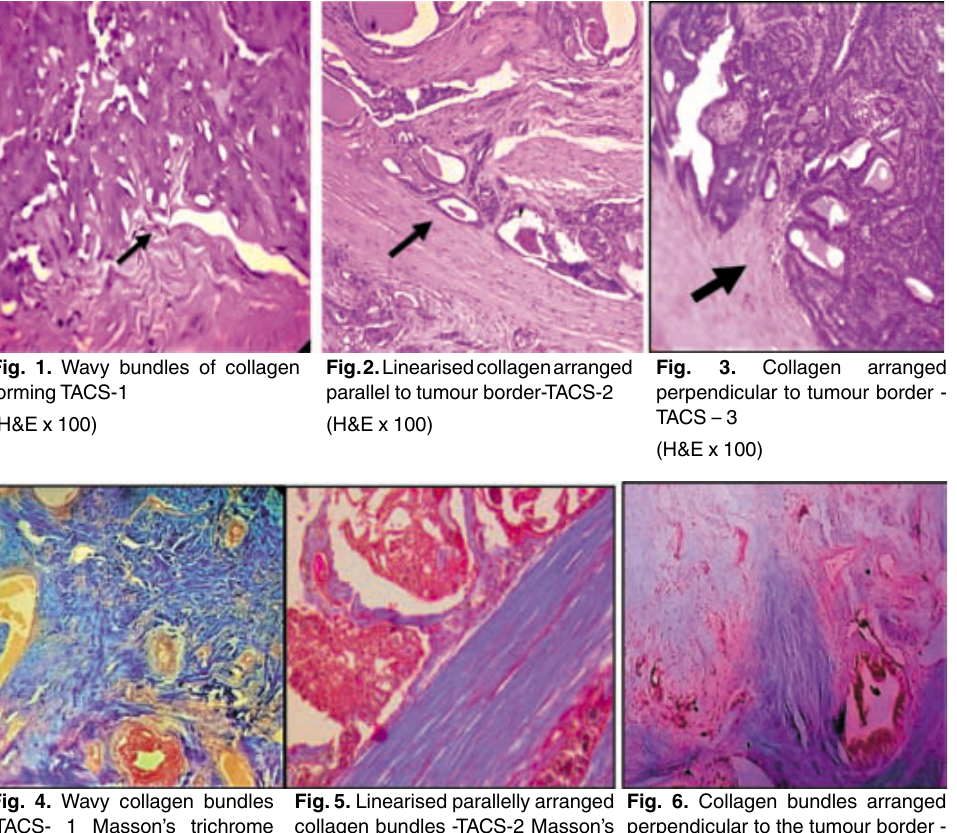
Fig. 4. Wavy collagen bundles -TACS- 1 Masson’s trichrome x100